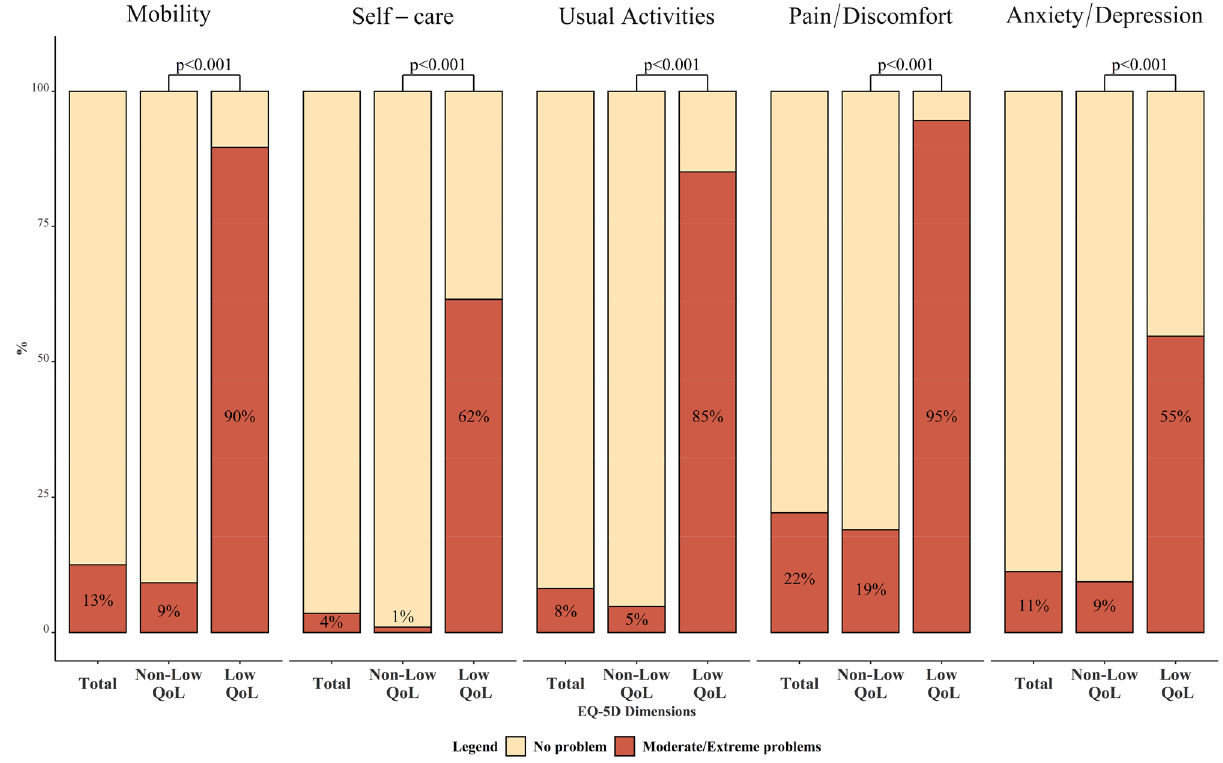
Figure 1. Proportions of individuals reporting moderate or extreme problems in HRQoL dimensions in the Total population, Non-Low-HRQoL, and the Low-HRQoL population. P -values were obtained from the Chi- square test to compare the proportion of reporting problems in EQ-5D